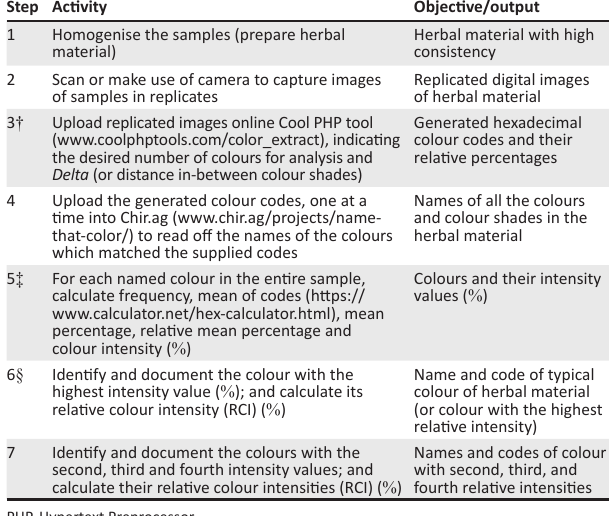
FIGURE 1: Images of the powdered medicinal herbs prepared for colourimetric TABLE 4: Procedure for computer-aided colorimetric evaluation of herbal material.